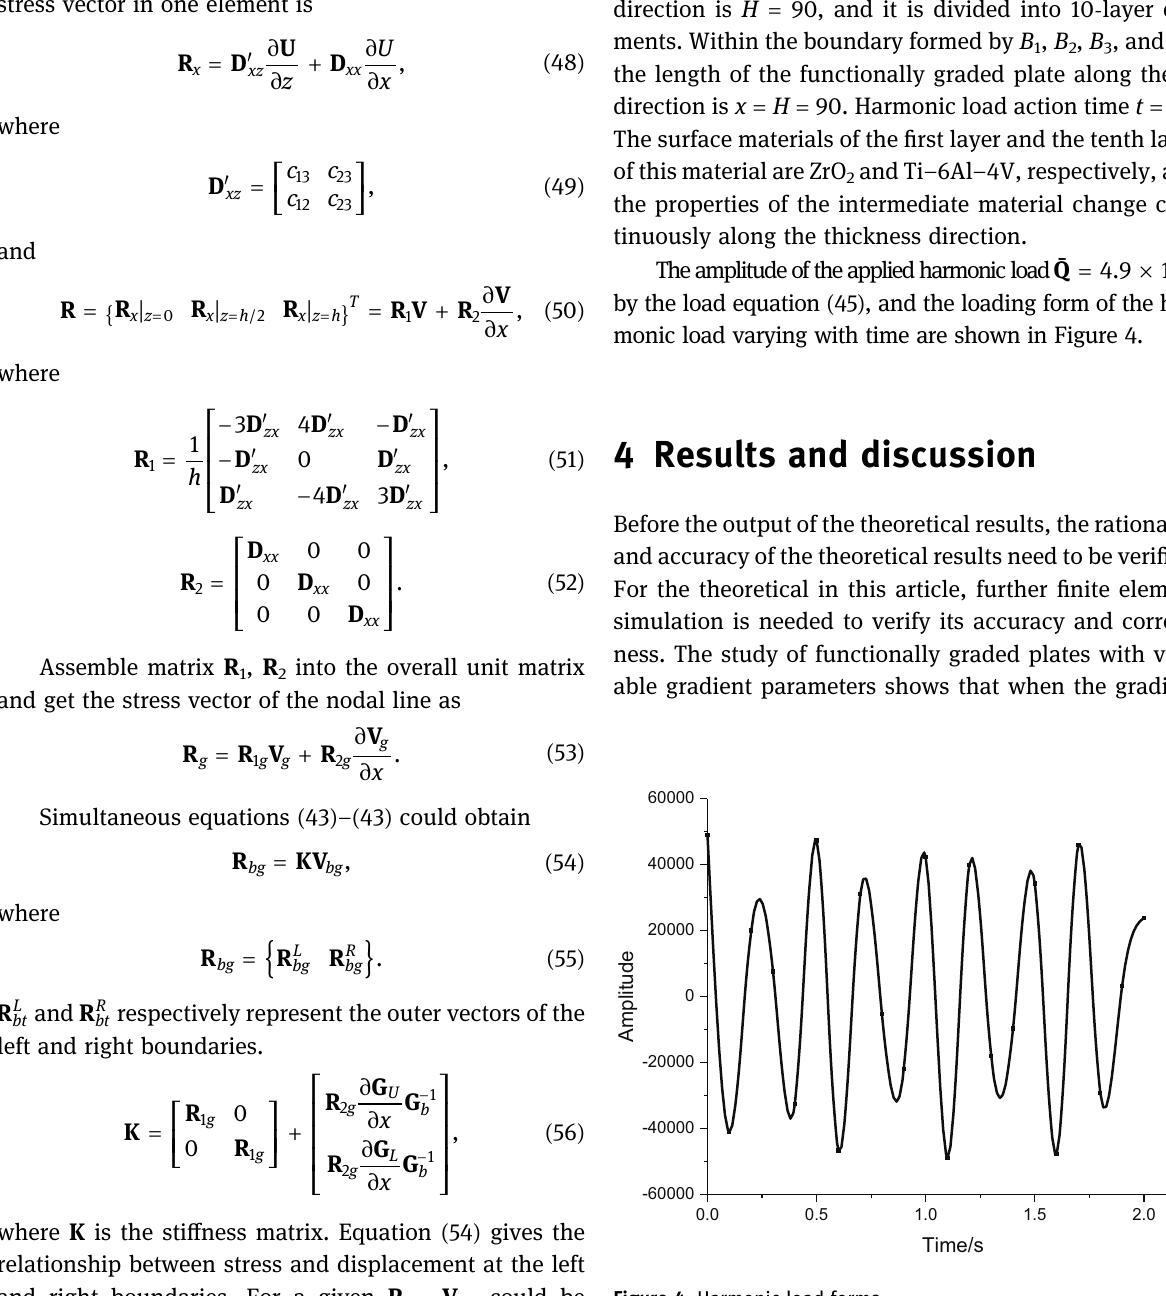
Figure 4: Harmonic load